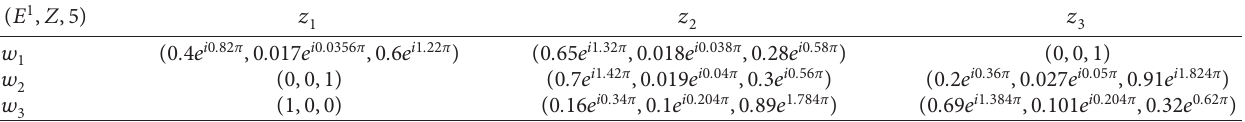
Table 17: CSFS S related with ( E, Z, 5 ) and threshold f